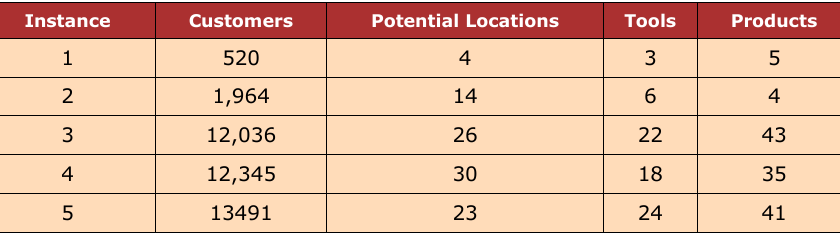
Table 1. Real-life network design test